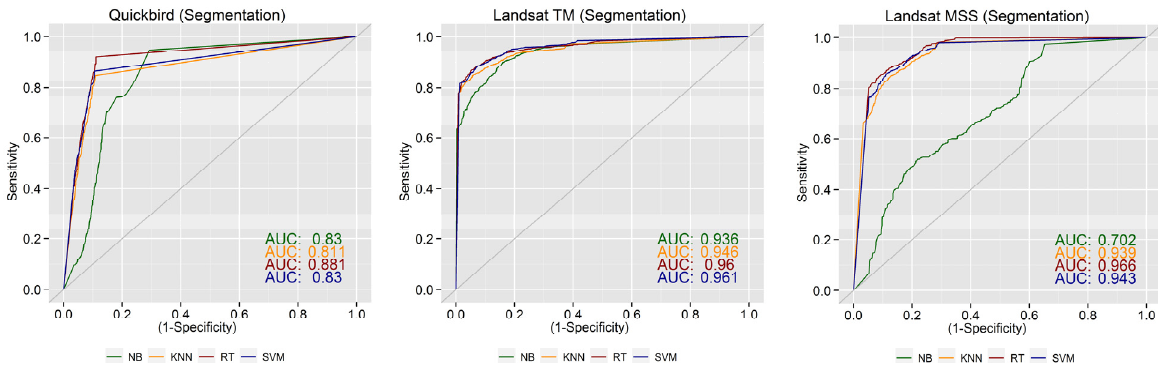
Figure 13. ROC curves for the classification of QB, TM and MSS, depicting the performance of different classifiers under varying segmentation